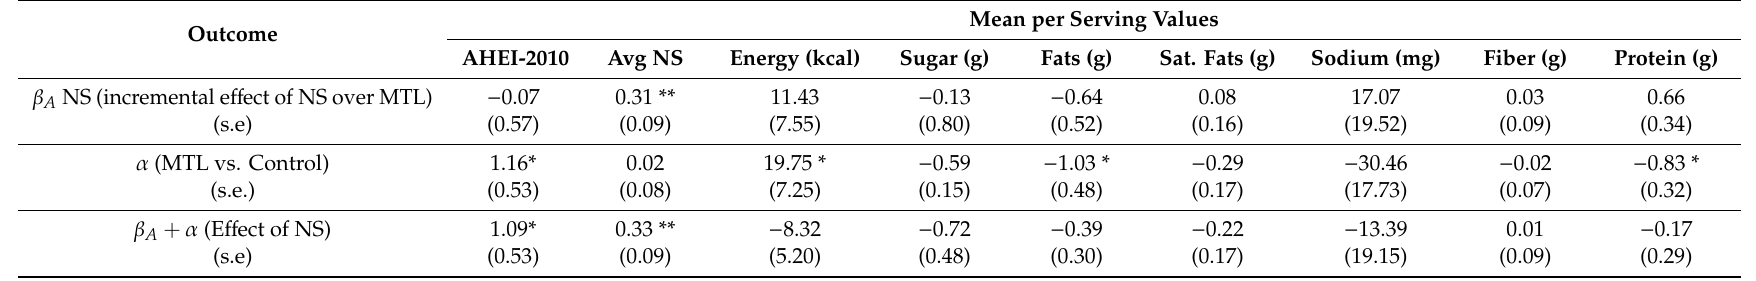
Table A1. Regression with dietary quality outcomes and per serving outcomes ( N , the number of di ff erences = 292, n, the number of individuals = 147).